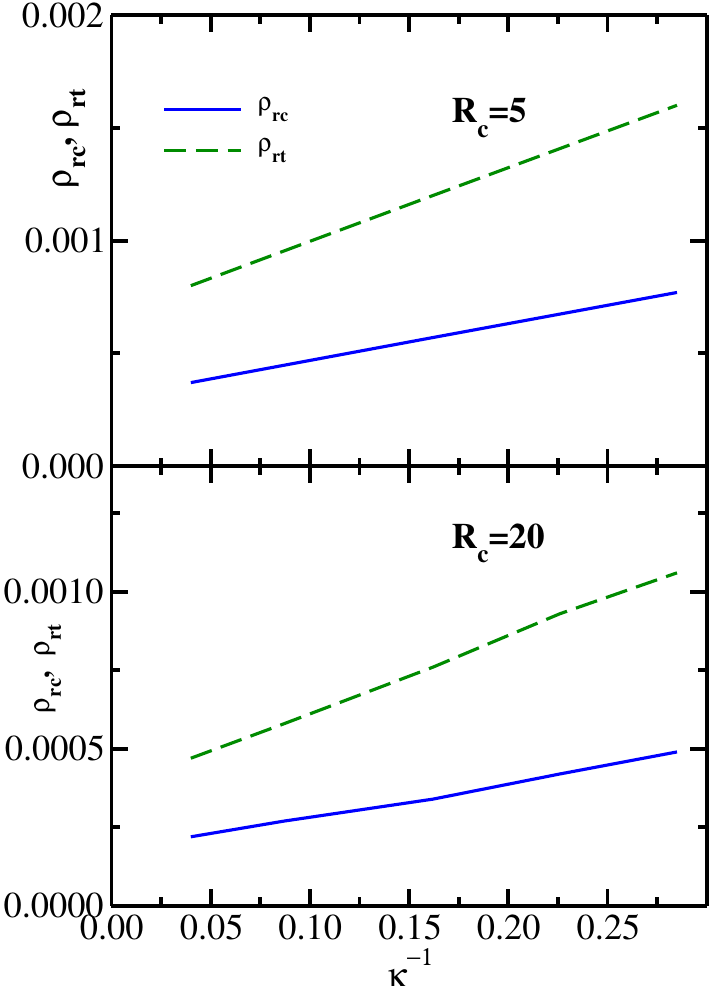
Figure 4. The monomer reservoir density corresponding to the liquid–vapor critical point ρ rc and to the vapor–liquid–solid triple point ρ rt as functions of the inverse stiffness parameter κ − 1 . Upper panel: colloid radius R c = 5; Lower panel: colloid radius R c =